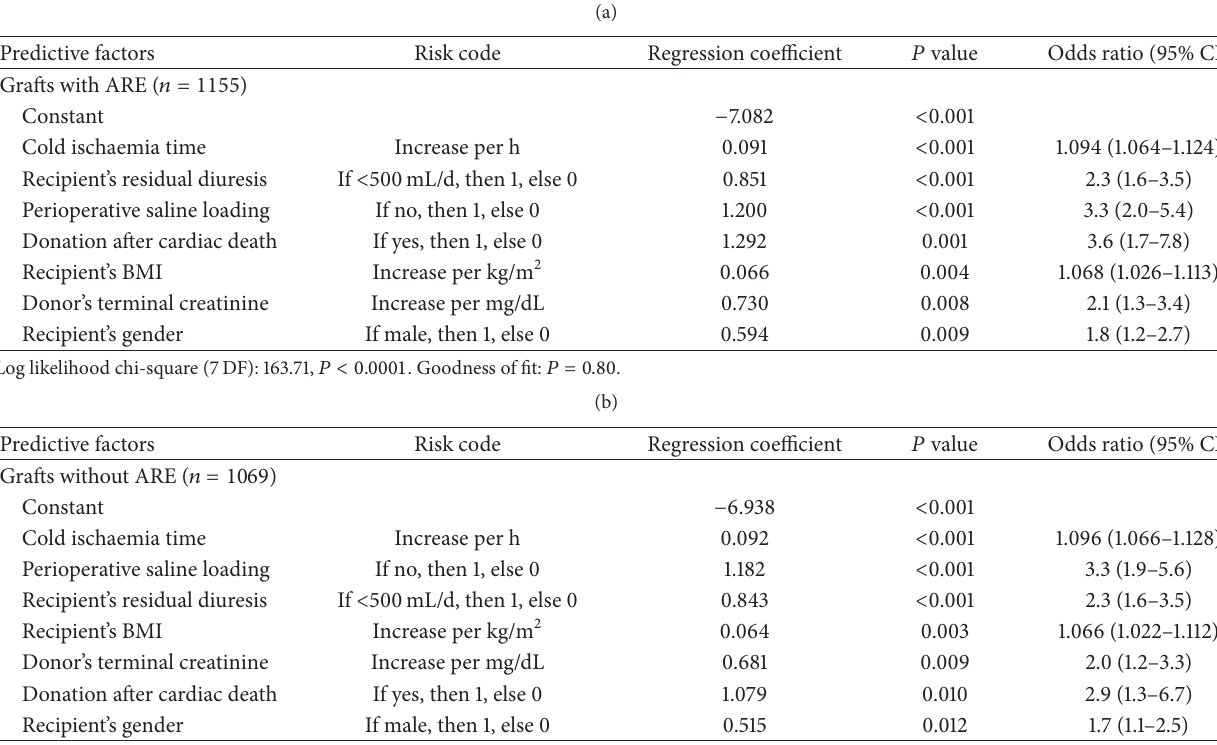
Table 5: Logistic regression analysis of factors predicting delayed graft function (DGF) with and without acute rejection episodes (ARE) occurring during the DGF period (grafts with complete